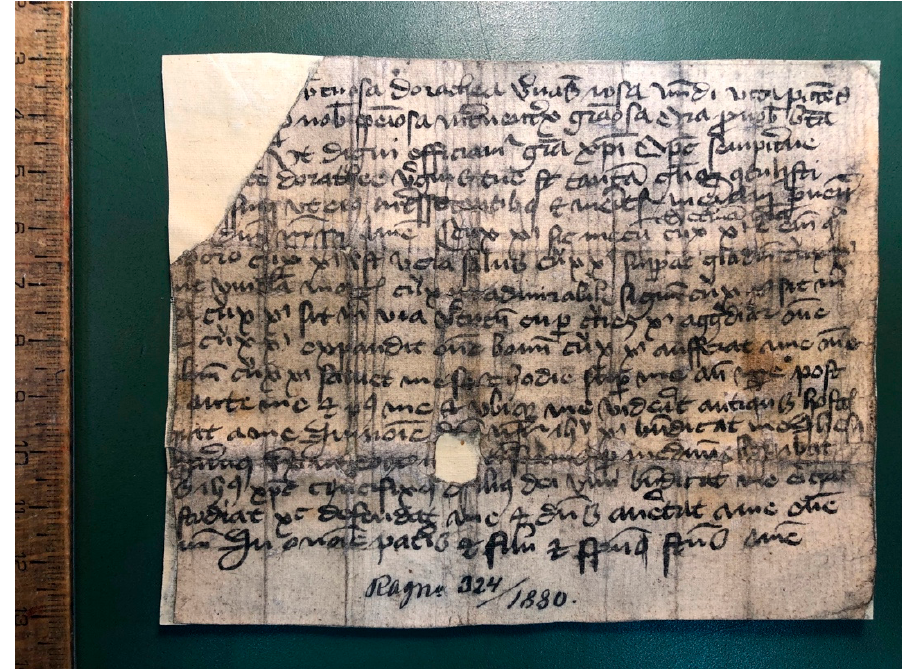
Figure 3. The amulet from Torpo, Latin prayers. Ink on paper, 1450–1500. Photo: Kaja M. H. Hagen.